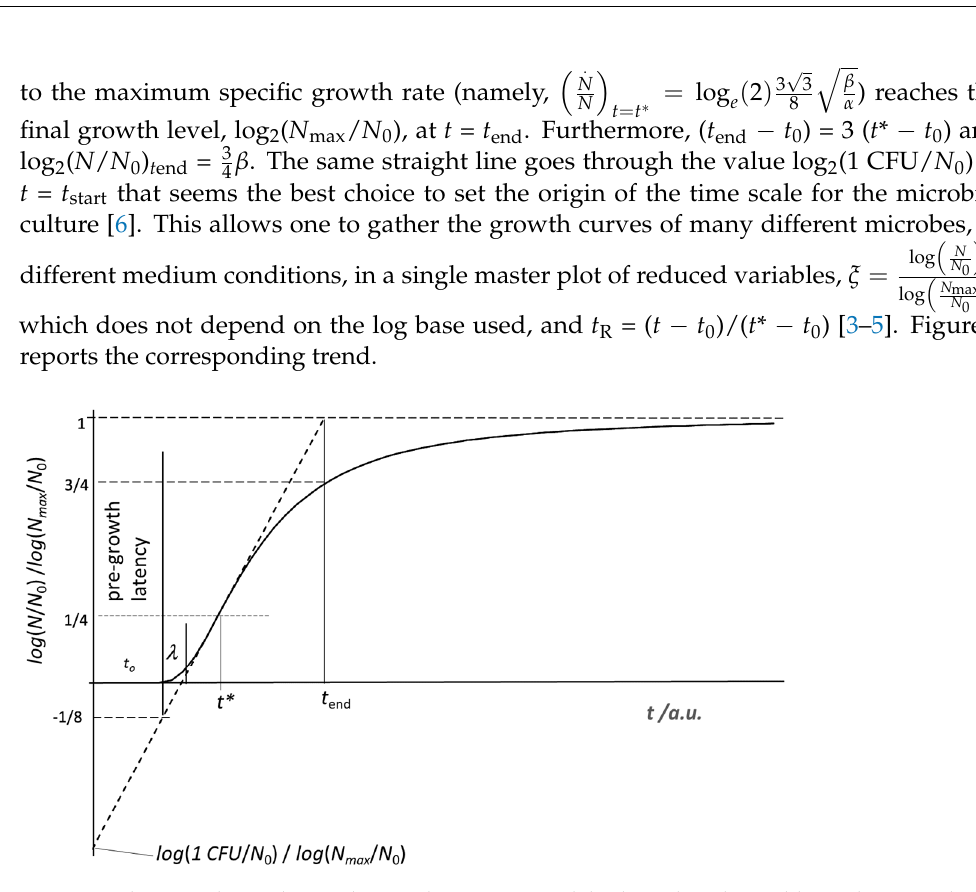
Figure 1. The growth trend according to the present model. The reduced variable on the y-axis holds for any log base. The intercept of the straight line tangent (dotted line) to the growth curve at t = t * dictates the “true” (for the microbial culture) origin of the time scale ( t = 0), which can be different from the start of the experiment. It is worth noticing the neat distinction between the pre-growth latency, t 0 , and the lag phase, λ , considered in most models reported in the literature [10].